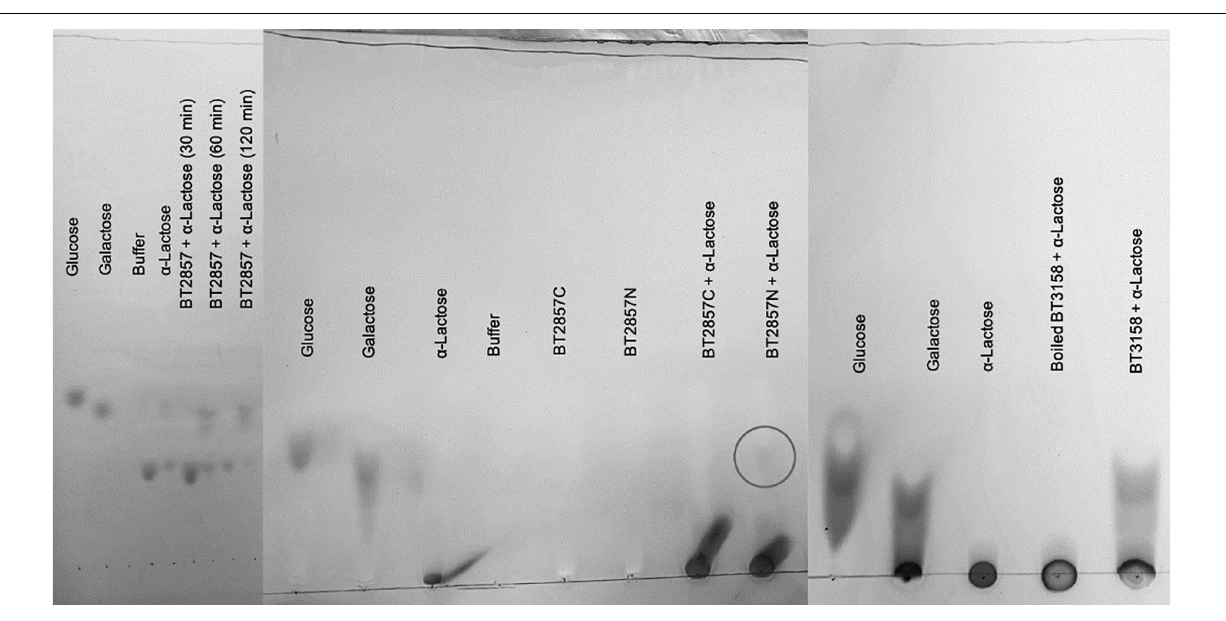
FIGURE 8 | Thin Layer Chromatography analysis of alpha lactose degradation by BT2857 and BT3158. Degradation of α -(1,4)-lactose was observed by BT2857 (full length), BT2857N, and BT3158 by the appearance of a spot further from the origin compared to undigested α -(1,4)-lactose (circled for BT2857N in the middle panel). Figure compiles three separate TLC